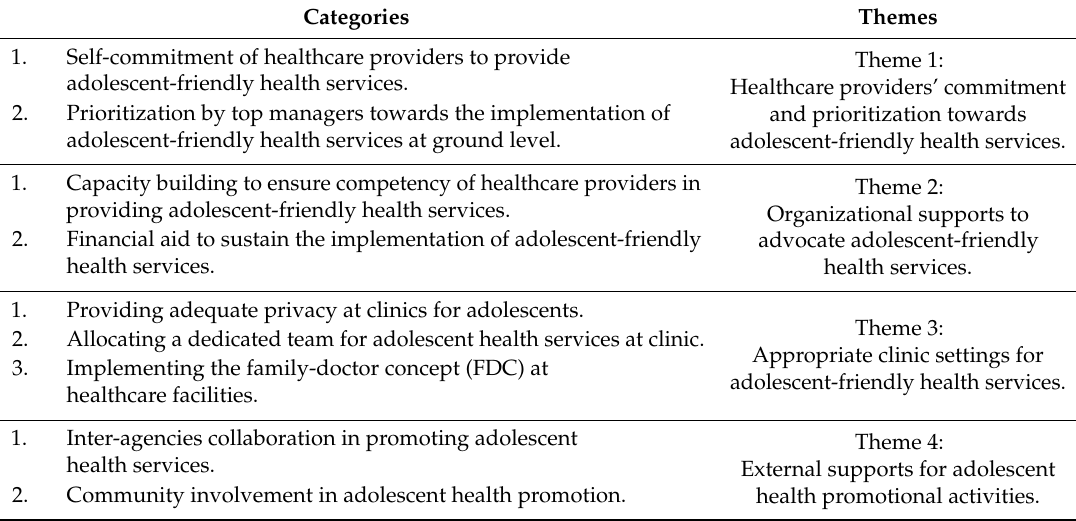
Table 3. Categories and final themes on the facilitating factors for adolescent-friendly health